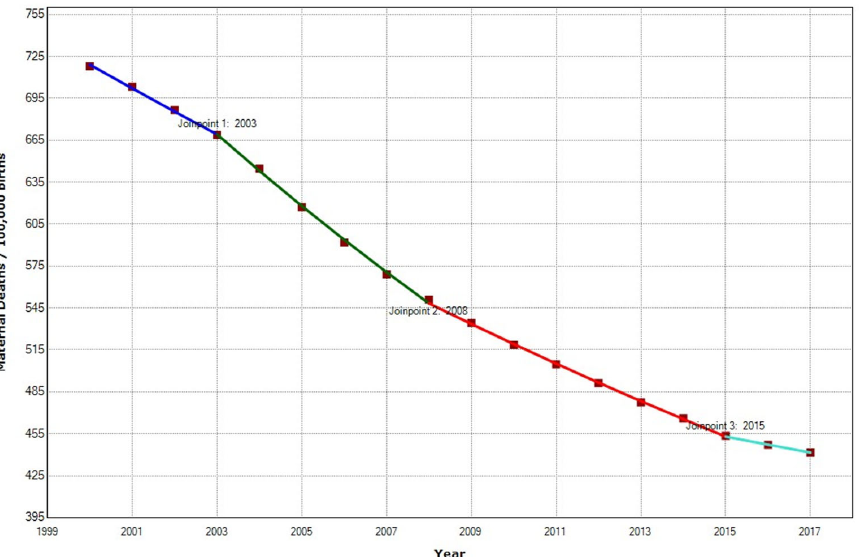
Figure 4. Maternal Mortality trends in Africa (2000–2017) indicate joinpoints at the transitions between colored lines. Table 1. Joinpoint analysis for maternal mortality rates in Africa, 2000–2017.